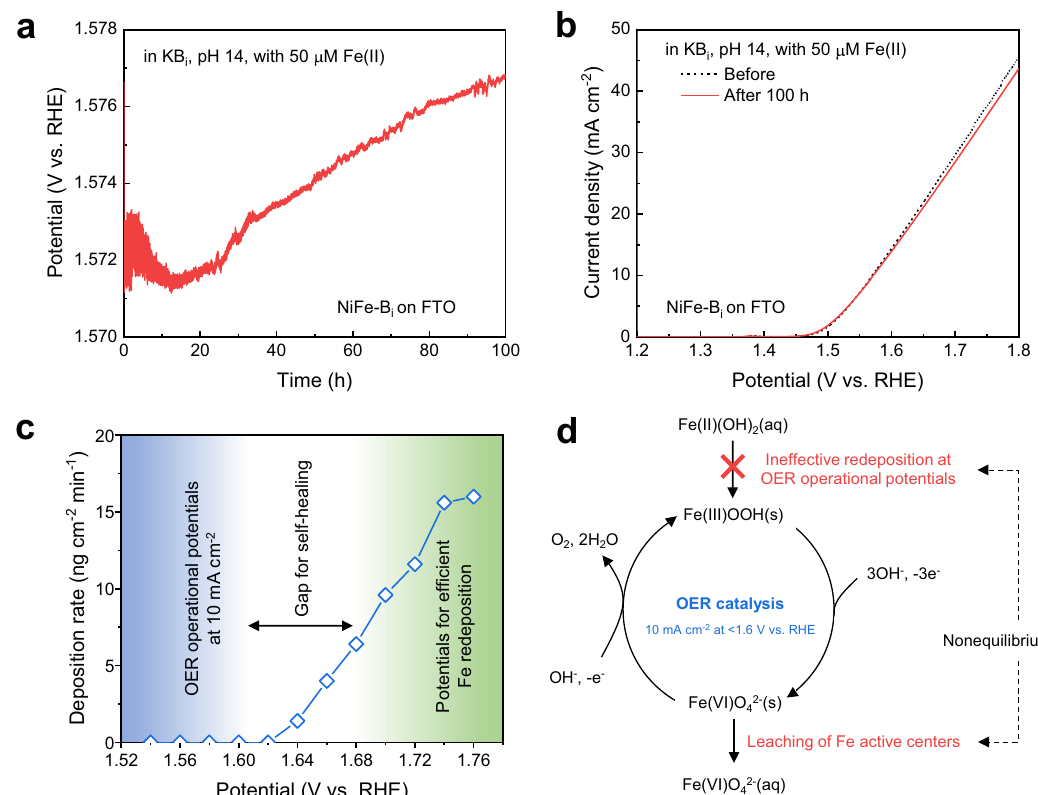
Fig. 1 Possible reason for the failure of self-healing in NiFe-LDH catalyst. a Stability test of the NiFe-B i catalyst measured at constant current density of 10 mA cm − 2 for 100 h in KB i electrolyte at pH 14 with 50 μ M Fe(II) ions. b The OER polarization curve of the NiFe-B i catalyst before and after the stability test. The curves were measured at 1 mV s − 1 scan rate, without iR correction. c Deposition rates of Fe hydroxides on EQCM sensors at different potentials in Fe-containing KB i electrolyte. The gap between the blue and green regions illustrates the mismatch between the OER operational potentials and the potentials required for ef fi cient Fe redeposition. d Proposed mechanism for the failure of self-healing in Fe-based catalysts. The OER catalysis is simpli fi ed by considering FeO 4 2 − as a representative active intermediate that is not thermodynamically stable and could leach out of the